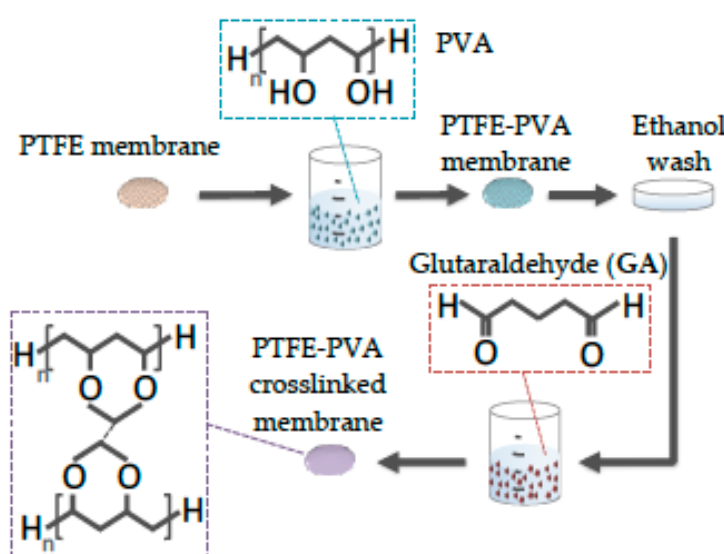
Figure 1. Step-by-step depiction of polyvinyl alcohol (PVA) deposition and cross-linking on polytetrafluoroethylene (PTFE) membrane.